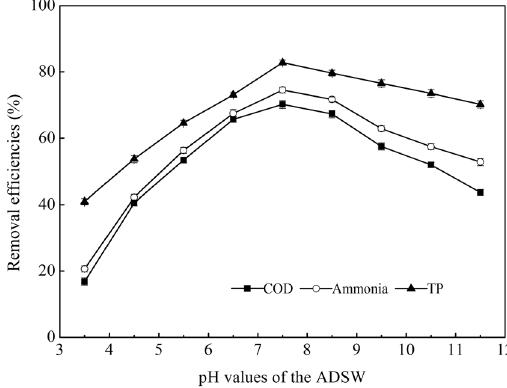
Figure 2. Effects of solution pH on ADSW treatment.